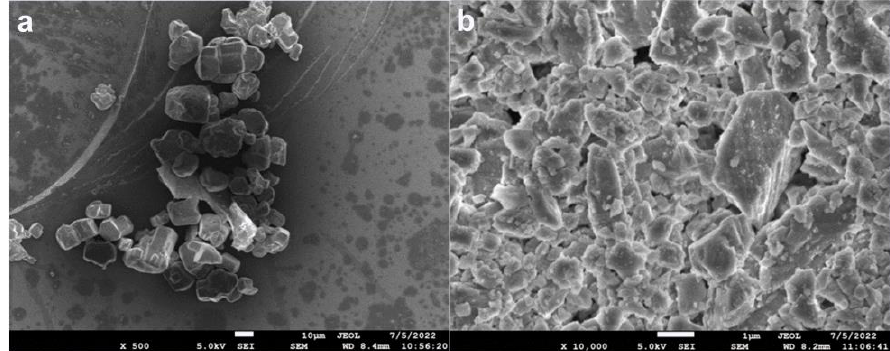
Figure 1. SEM images of commercial APP(a) and CaCO 3 (b).